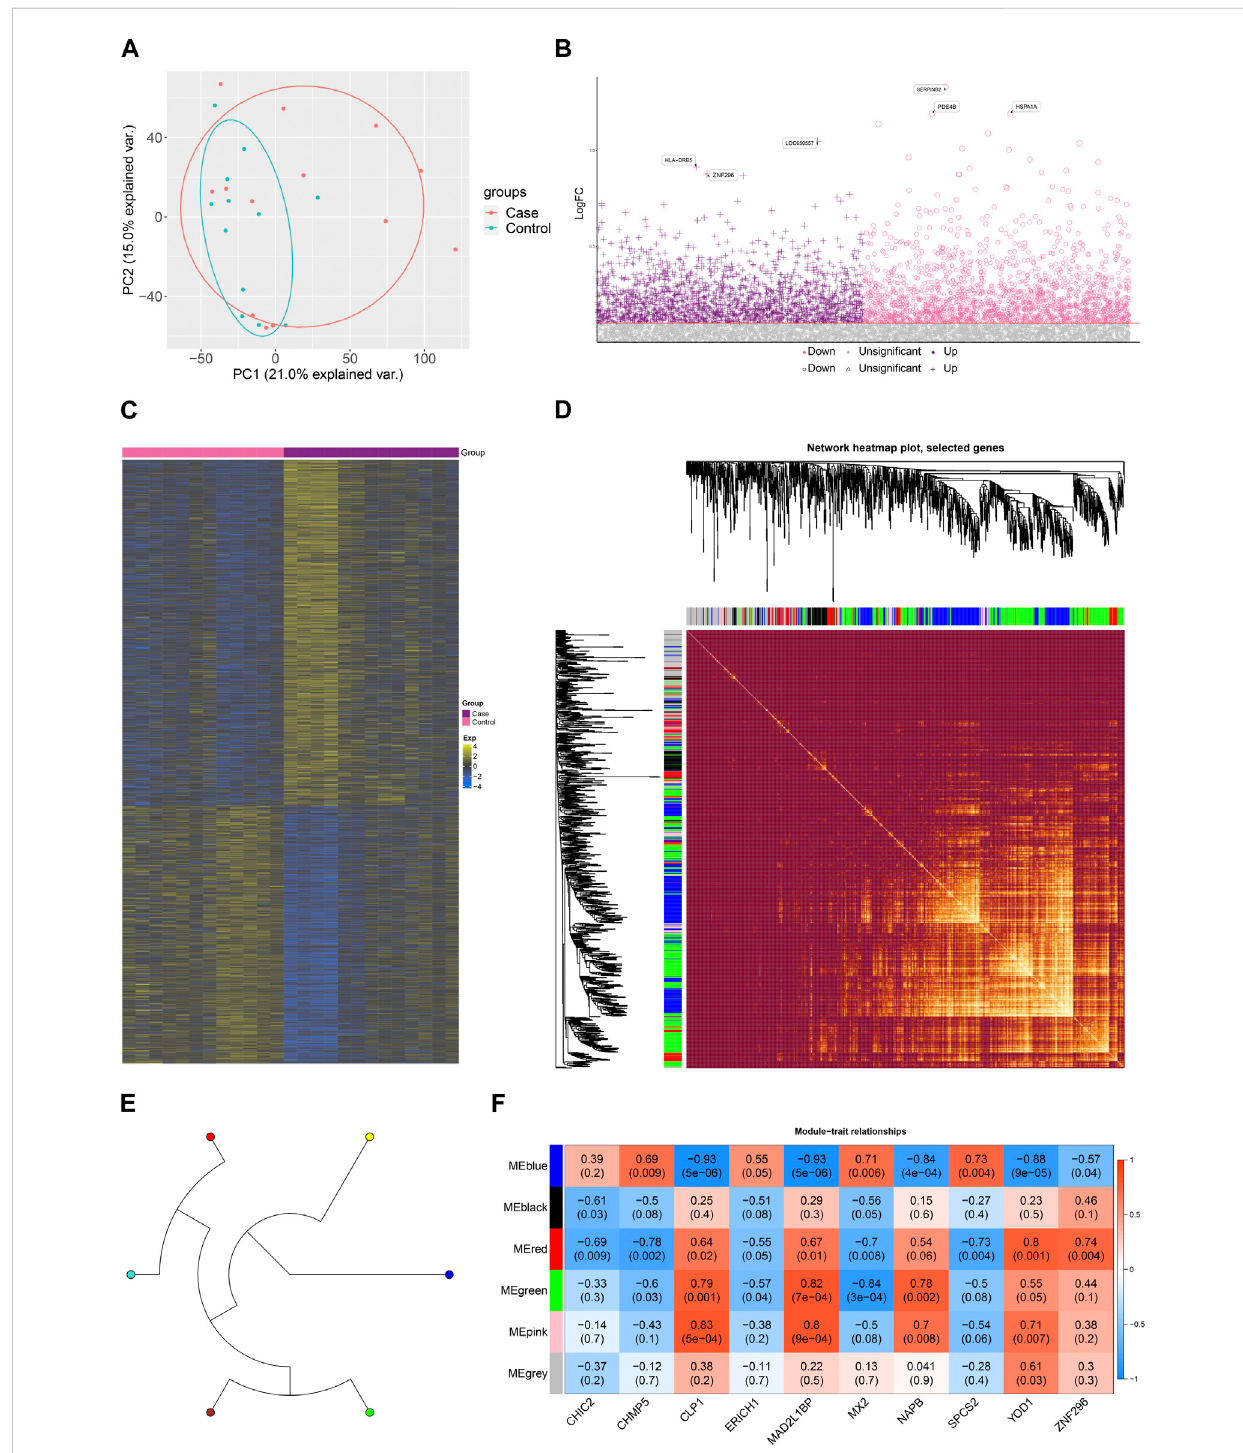
FIGURE 2 Dysregulated gene co-expression modules characterize the global regulatory pattern of myasthenia gravis. (A) . Principal component analysis (PCA) plots showing signi fi cant differences between disease and control. (B) Manhattan plots showing differential expression of Case-Control. (C) Heat map showing expression of dysregulated genes in Case-Control groupings. (D) . Module ring tree plots showing neighboring relationships between dysregulatedgeneco-expressionmodules. (E) Moduleheatmapshowinggenemembersofdysregulatedgeneco-expressionmodules. (F) Module correlation plot showing the expression correlation of gene co-expression modules with Top10 signi fi cantly dysregulated